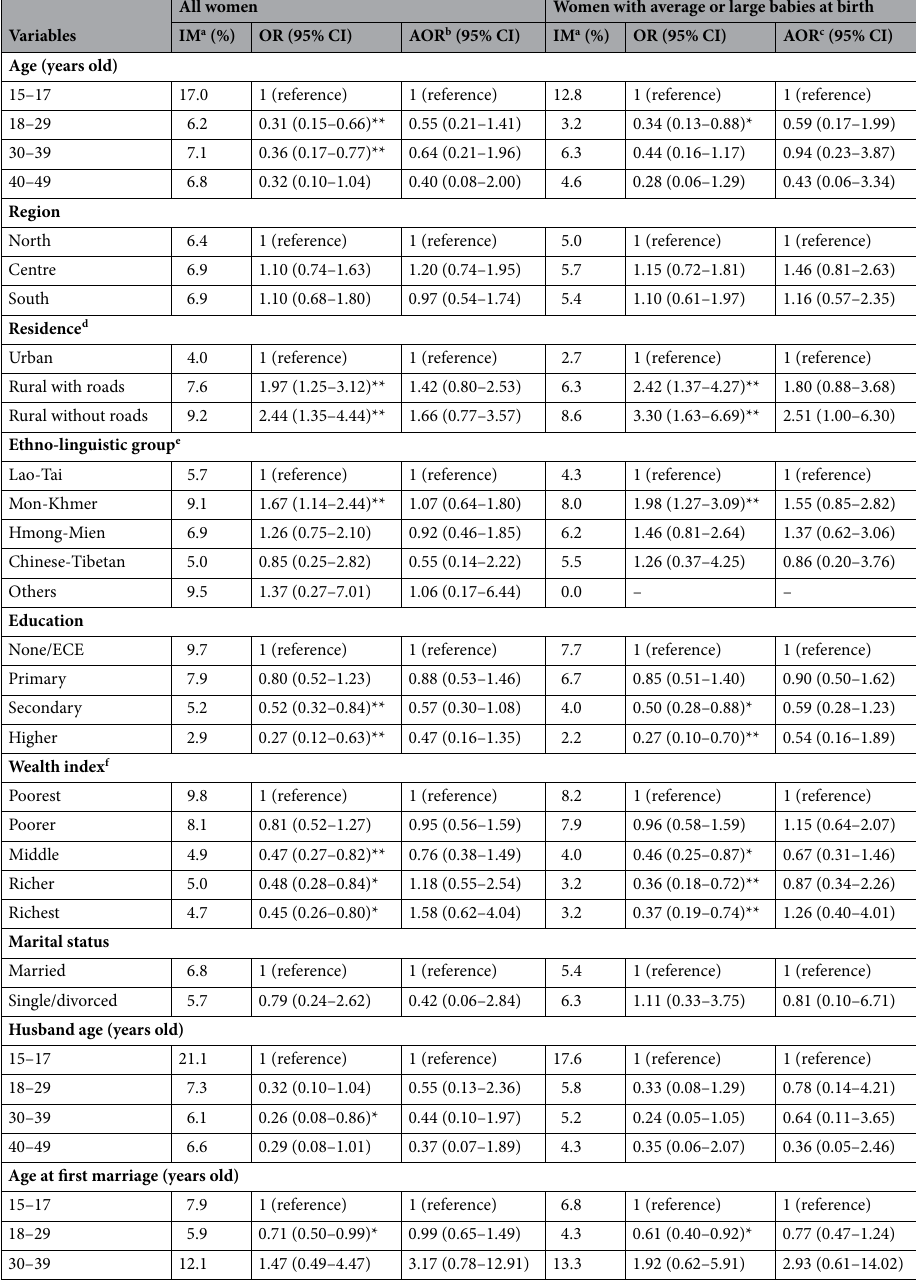
Table 1. Comparison of socio-demographic factors according to infant mortality. IM infant mortality, OR odds ratio, AOR adjusted odds ratio, CI confidence interval, ECE, early childhood education. *P < 0.05. **P < 0.01. a Sampling weights were applied. b Adjusted for all variables included in Tables 1, 2, 3. c Adjusted for all variables included in Tables 1, 2, 3 except cesarean delivery. d A village is classified as urban, rural with roads, or rural without roads based on its characteristic features 42 . e The ethno-linguistic groups were based on the ethnic categorization by the Lao government 43 . f The wealth index is a composite indicator of wealth 8